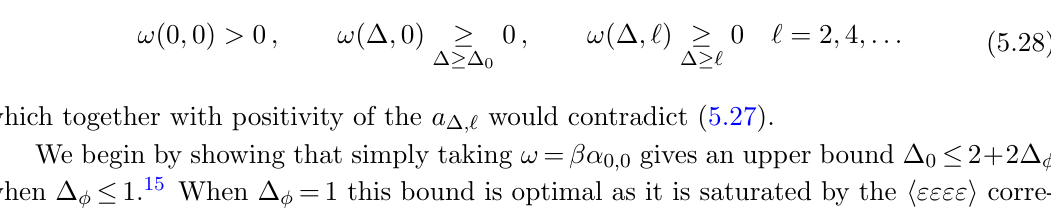
Figure 2 . Schematic plots of the functional actions (cid:11) + care about their positivity properties, we have rescaled them by non-negative functions of h for clarity. For (cid:1) (cid:30) < 1 the curves look similar replacing 4 ; 8 ; : : : by 2 + 2(cid:1) (cid:30) ; 4 + 2(cid:1) (cid:30) ; : : :